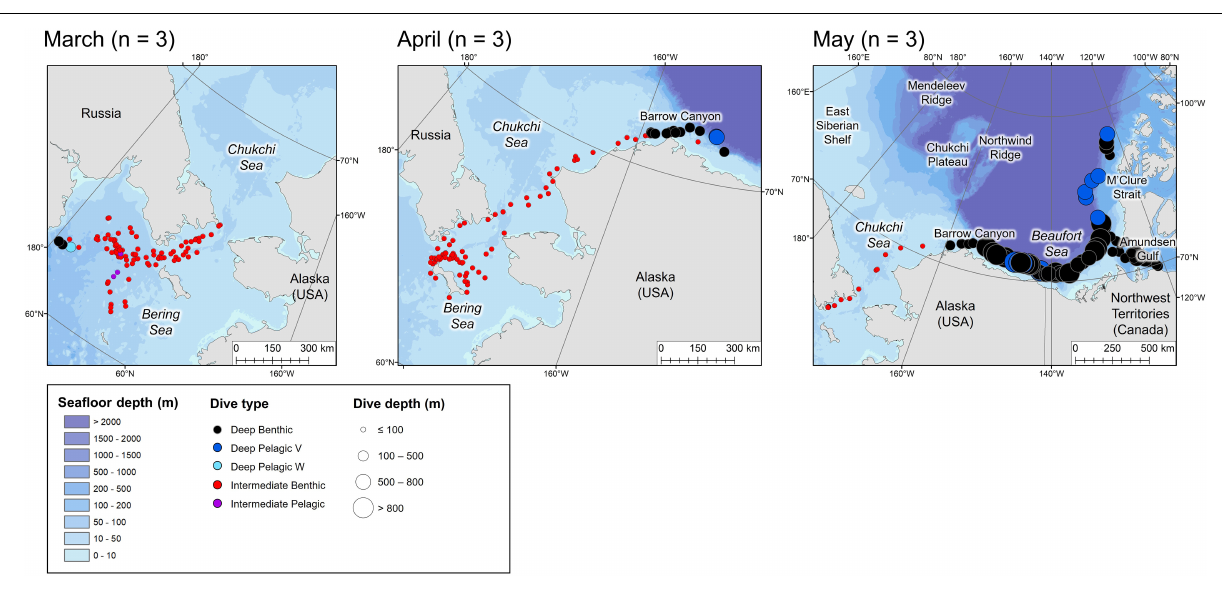
FIGURE 6 | Locations of the daily deepest dive made by each beluga during the spring months. Symbol color represents dive type and symbol size represents the maximum depth reached. n in parentheses gives the number of belugas which transmitted data in the given